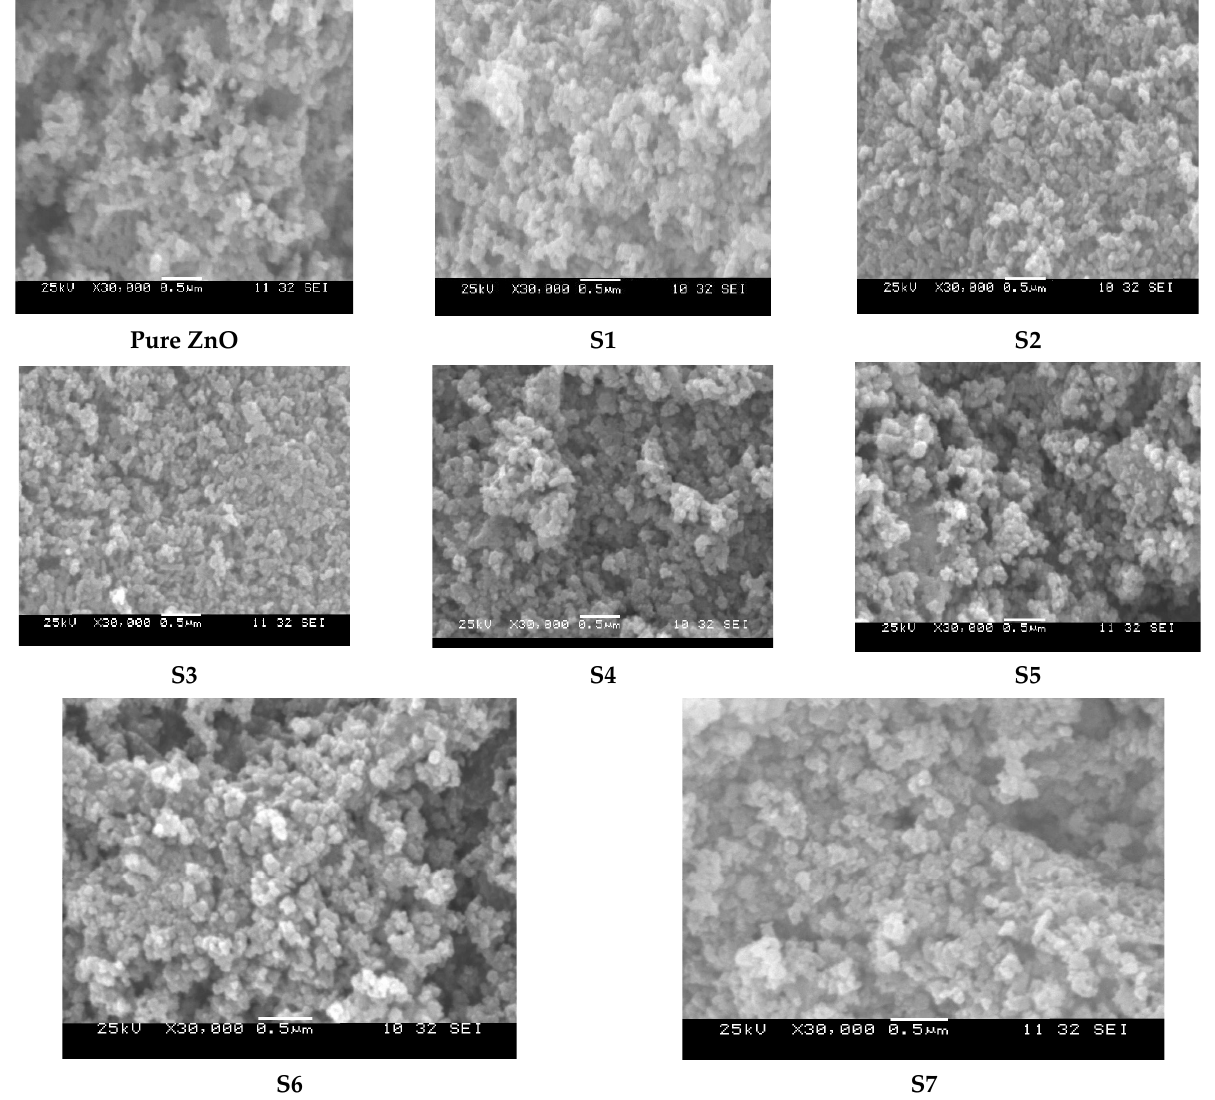
Figure 2. SEM images of pure and Eu 2 O 3 -doped ZnO nanostructured samples, with various euro- pium (Eu) doping ratios (0–5 g).